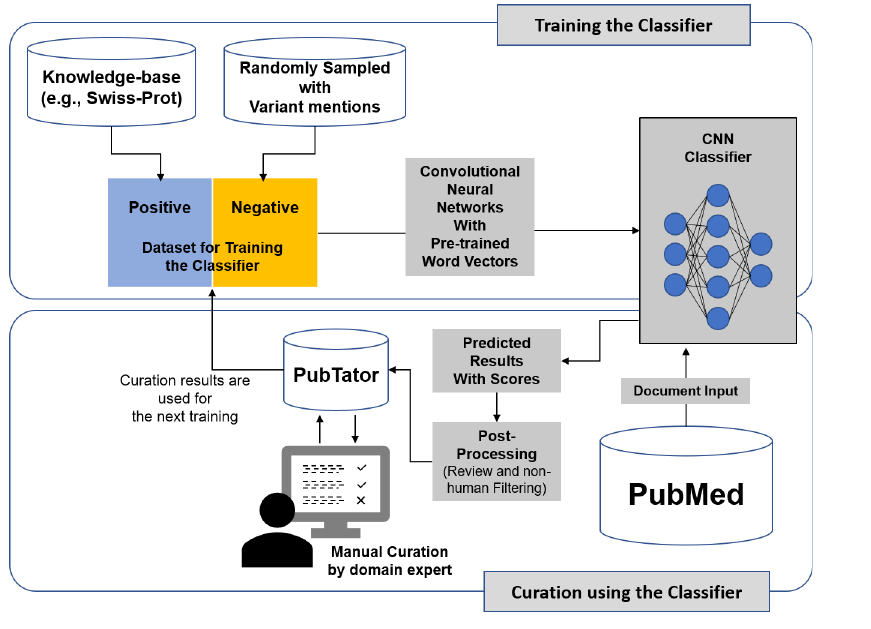
Fig 1. Literature triage using our deep learning framework.